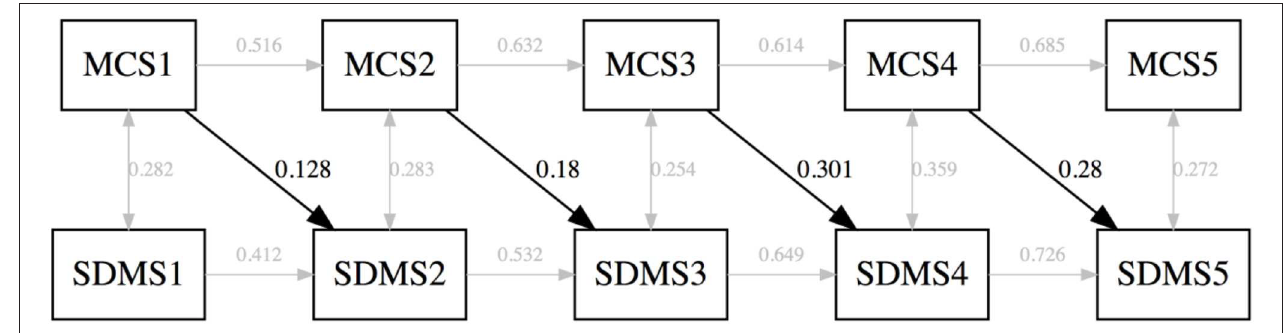
FIGURE 2 | Pearson’s correlations (black one headed arrows and gray double headed arrows) and reliability coefficients (test-retest correlation; gray one headed arrows).